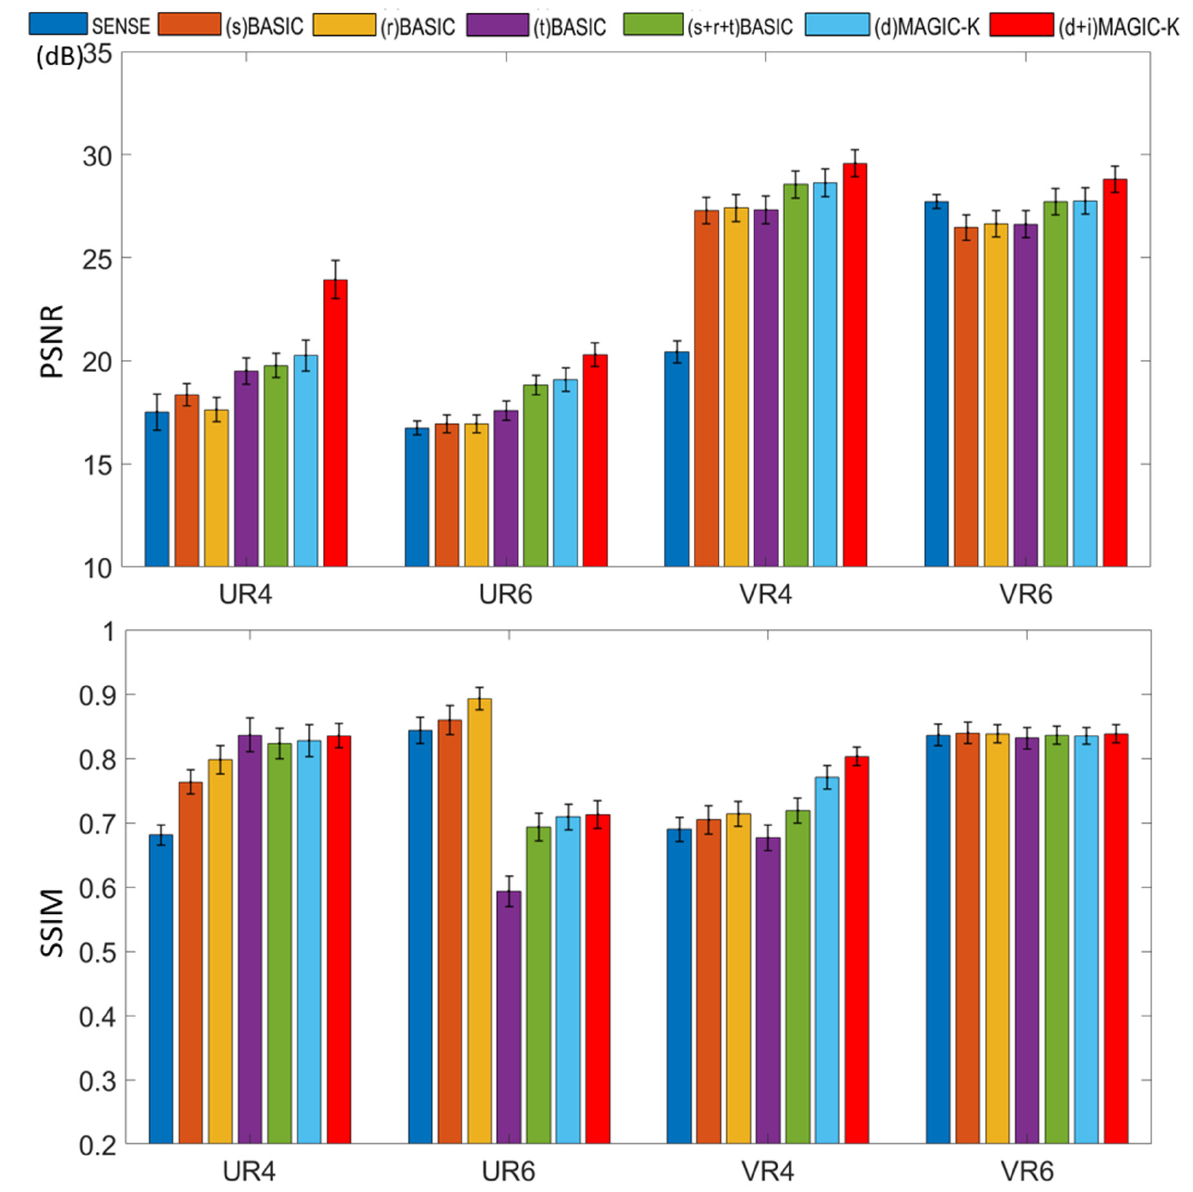
Figure 5. PSNR and SSIM of reconstructed images using different data augmentation strategies in healthy volunteers. U stands for the uniform undersampling strategy and V stands for the variable density undersampling strategy, and 4 and 6 stand for different acceleration factors, respectively.